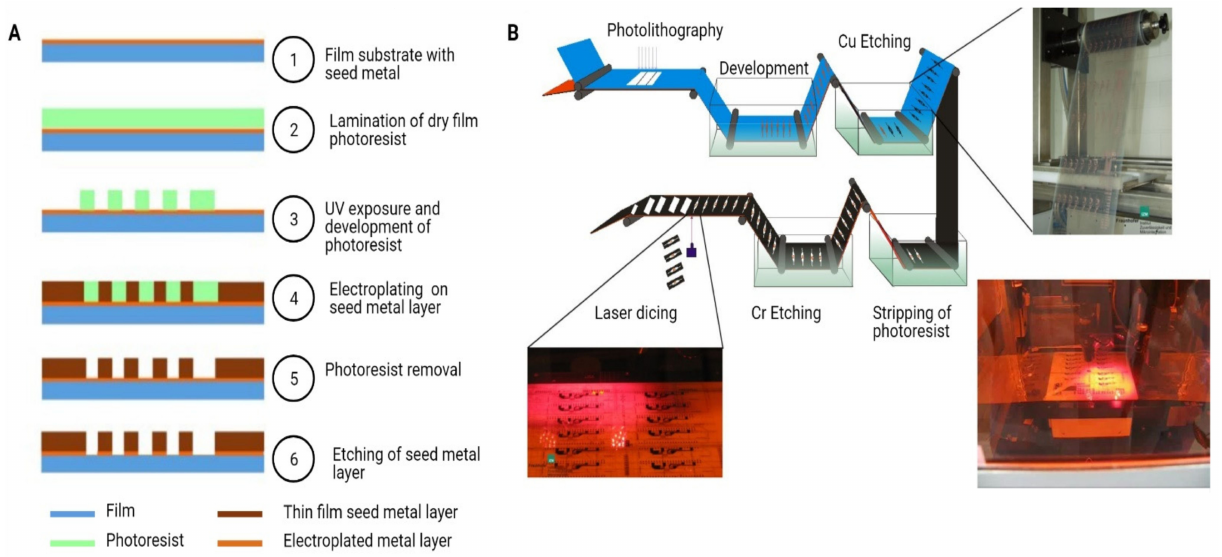
Figure 8. ( A ) Semi-additive roll-to-roll (R2R) processes for metal patterning from [224] under creative commons 3.0. ( B ) Schematic to show R2R processing, in copper, of impedimetric electrode layer in